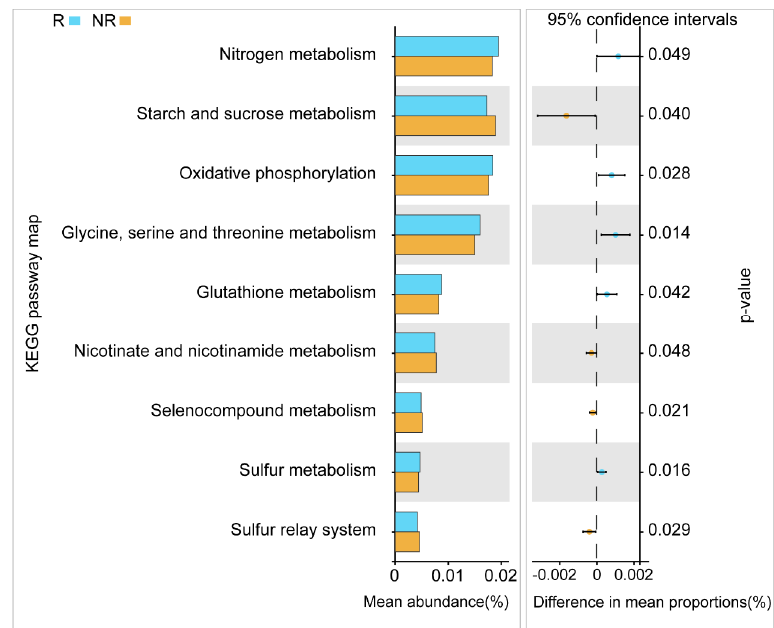
Figure 5. The difference Kyoto Encyclopedia of Genes and Genomes (KEGG) map of bacteria between rhizosphere (R) and non-rhizosphere (NR) based on Welch’s t-test. n = 3.